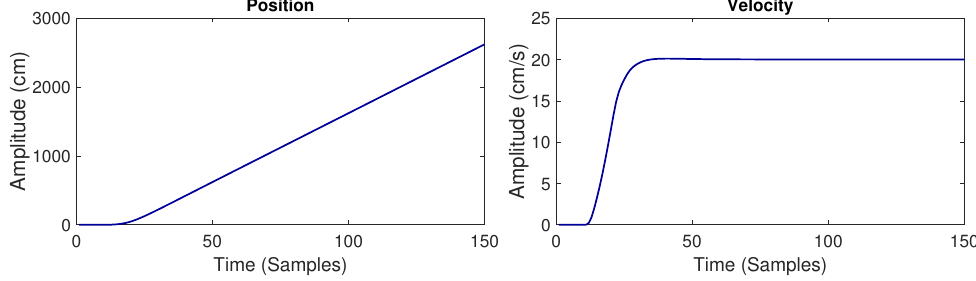
Figure 12. Position and velocity of the leader vehicle with a sample time of T s = 50 ms. The performance of the vehicle platoon for a platoon size of M = 40 is evaluated numerically through a Monte Carlo simulation with N = 5 × 10 5 realizations and for different values of the successful transmission probability p